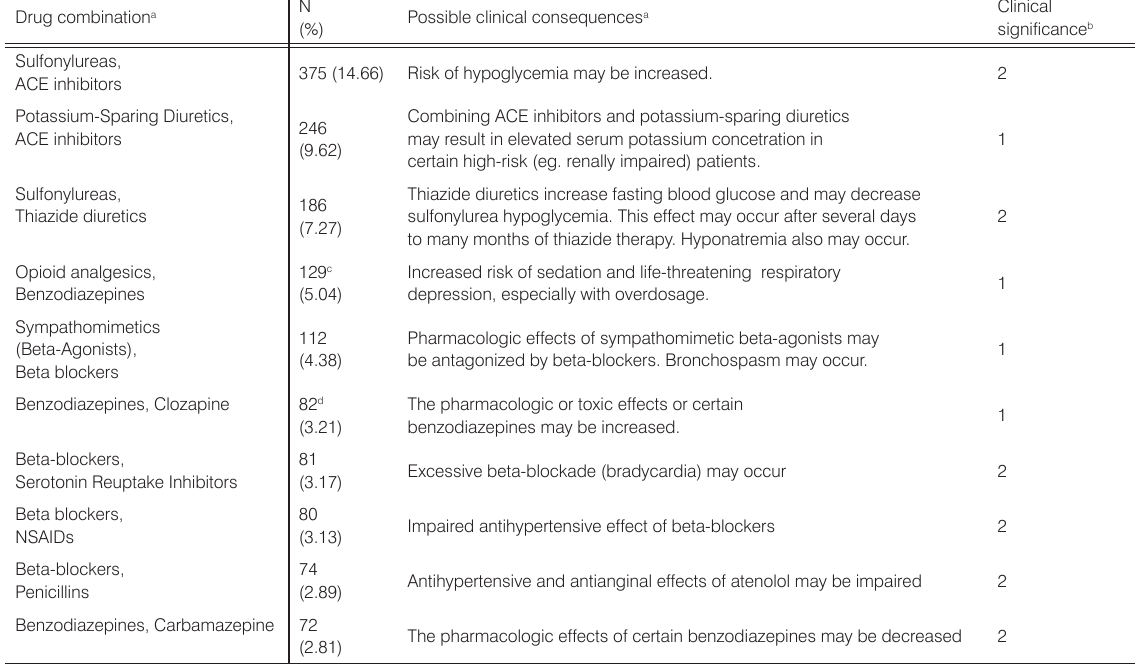
Table 2. Most common potential drug-drug interactions Drug combination a